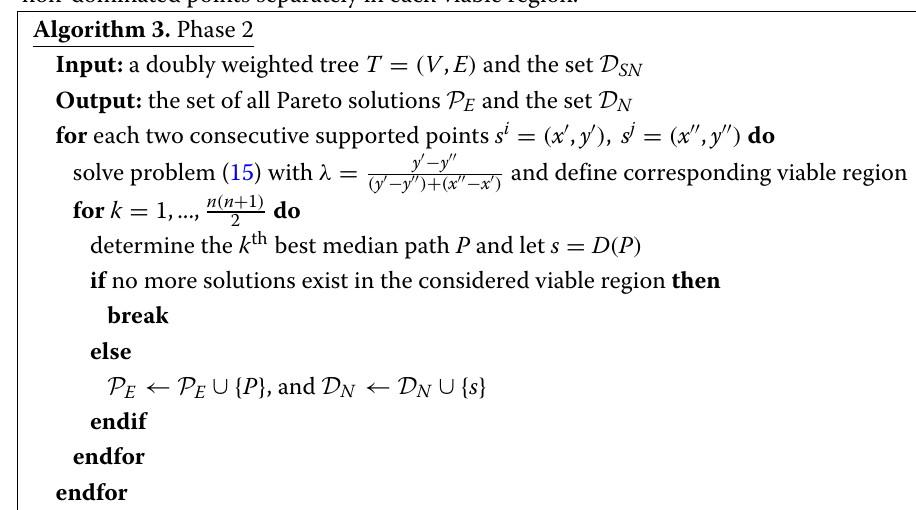
Algorithm 3. Phase